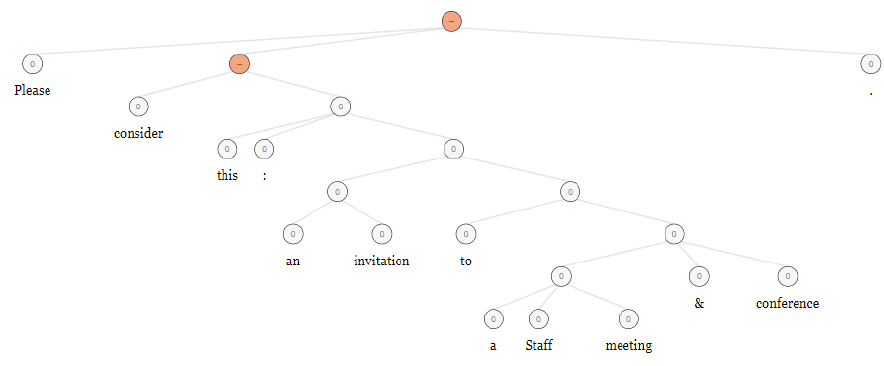
Figure 2. Example of RNTN ’ s Output After Training for Trust.